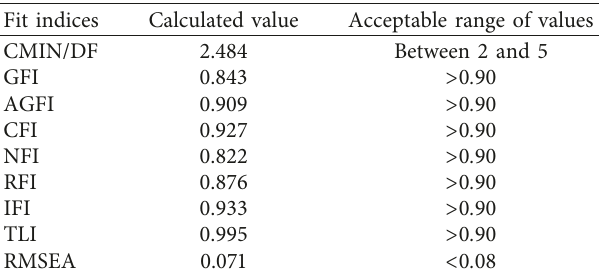
Table 6: Fit indices concerning the conceptualized path